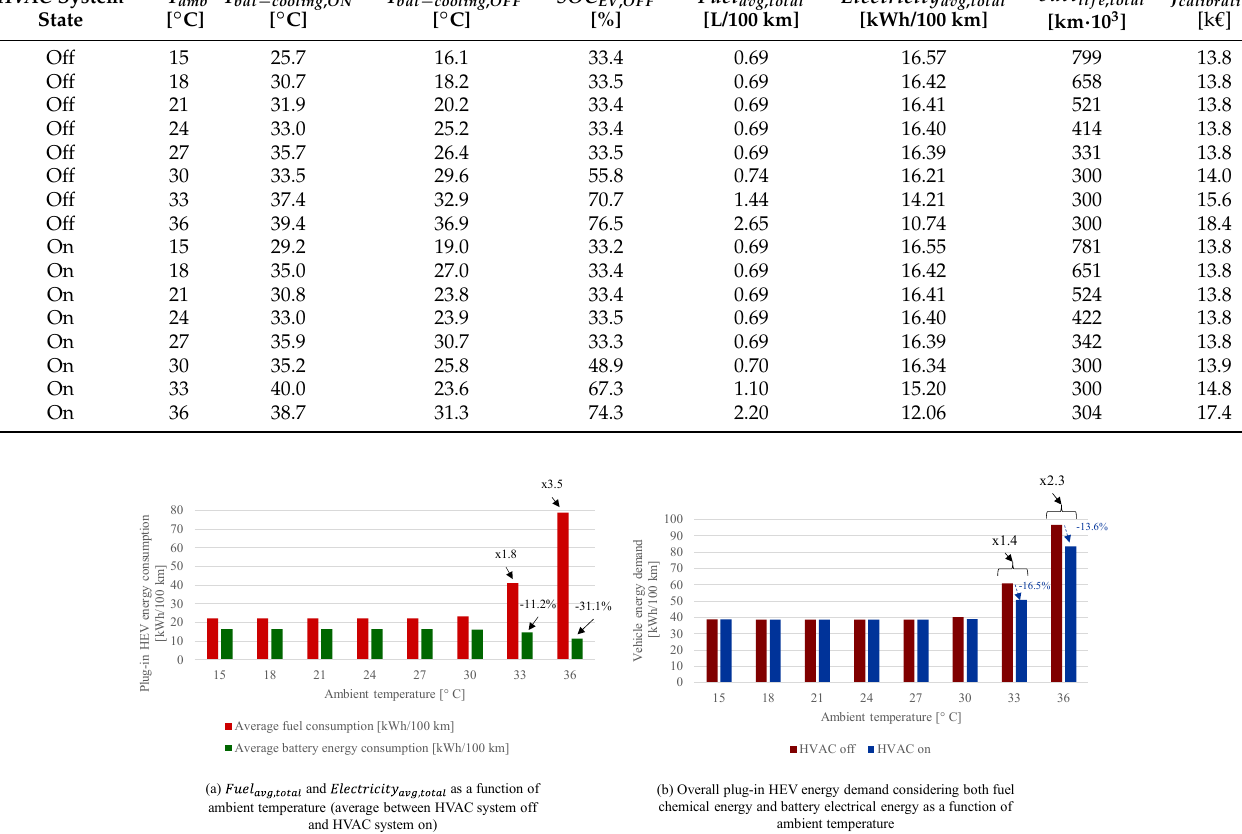
Figure 9. Plug-in HEV fuel consumption, battery energy consumption, and overall energy consumption as a function of the ambient temperature while benchmarking with corresponding values at 15 °C.